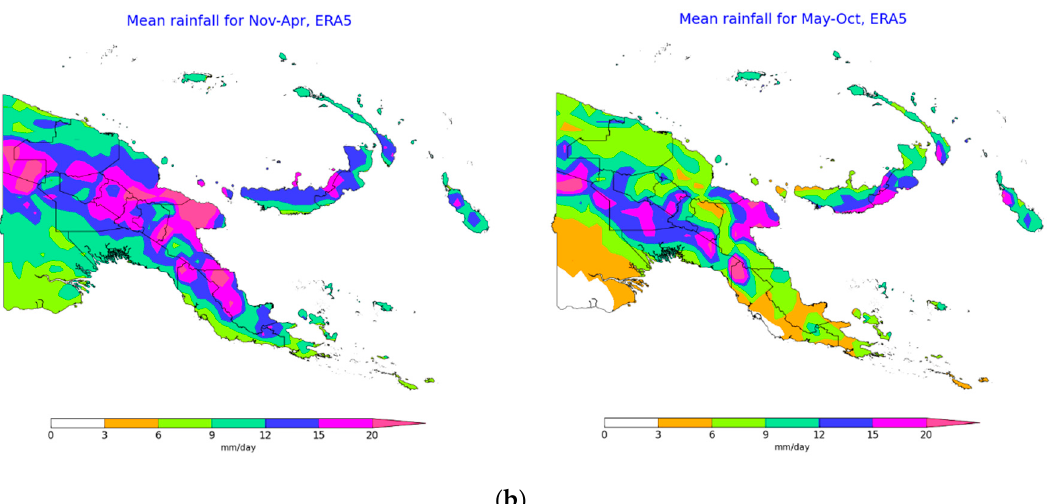
Figure 5. Seasonal mean rainfall from January 2001 to December 2018. Datasets used are Global Satellite Mapping of Precipitation (GSMaP) ( a ) and ERA5 ( b ).